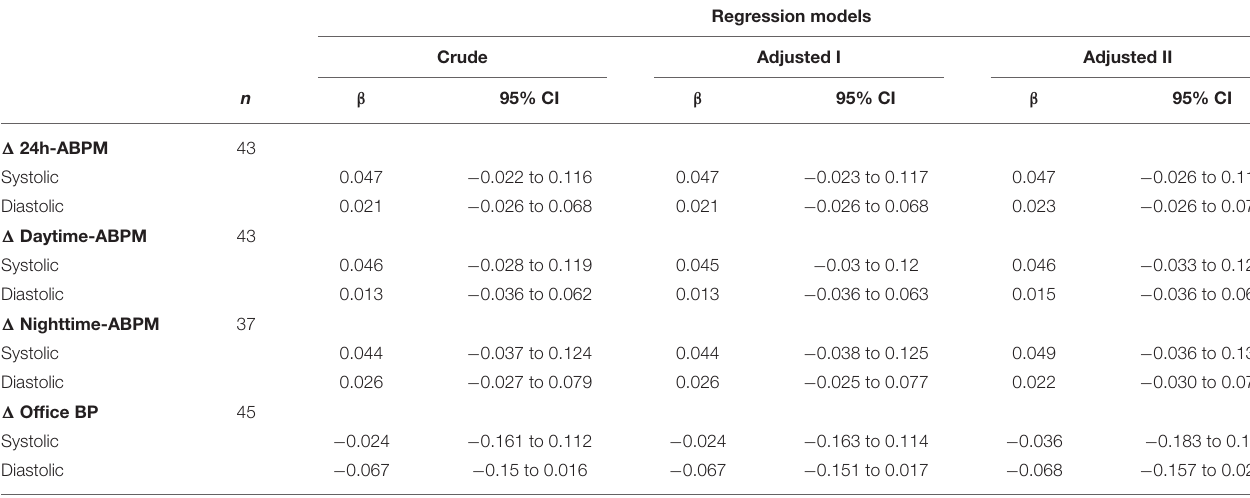
TABLE 3B | Association of systolic and diastolic blood pressure change (mmHg) with respect to sodium bicarbonate dose (mg/kg body weight).